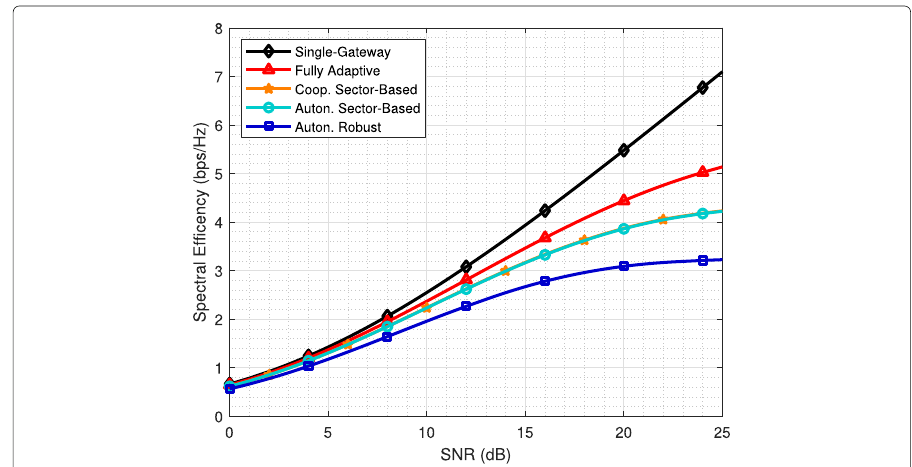
Fig. 9 Numerical results for 1 user per frame (unicast mode)